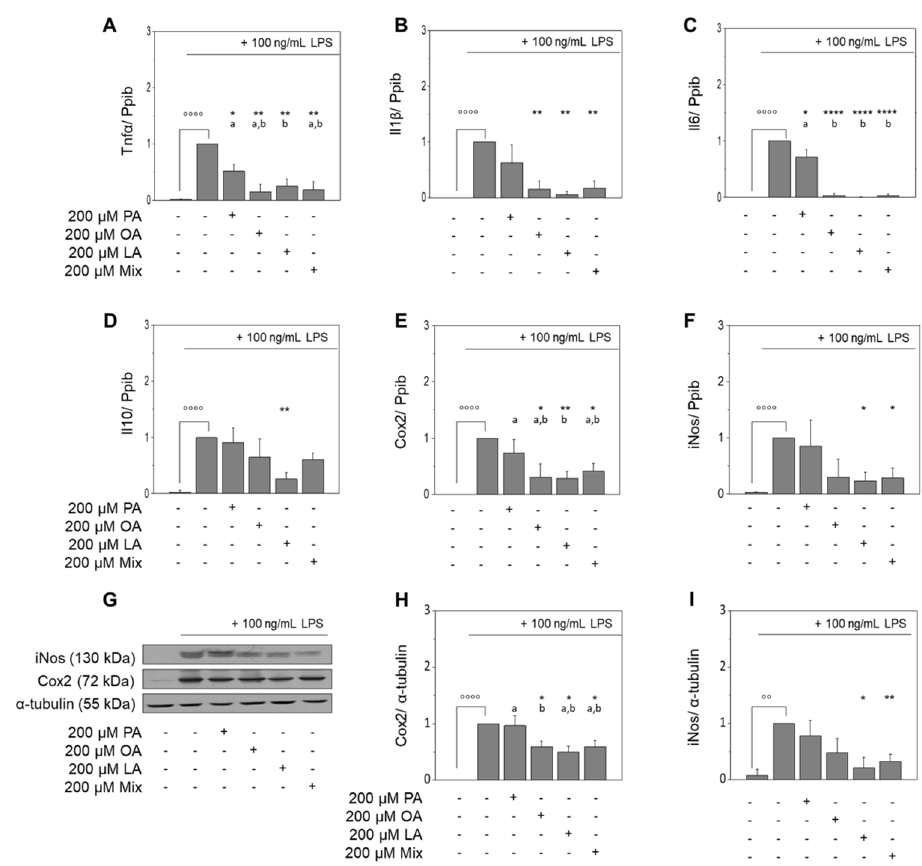
Figure 2. Effects of major fatty acids (FA) of extra virgin olive oil on the expression of inflammatory markers. Selected FAs diminished LPS-induced expression of Tnf α , Il1 β , Il6, and Il10 mRNA ( A – D ) and of iNos and Cox2 mRNA and protein expression ( E – I ) in murine RAW264.7 macrophages. Cells were pre-incubated with serum-free medium, oleic acid (OA), linoleic acid (LA), palmitic acid (PA), or a defined FA mixture (Mix) of the mentioned FAs (80:10:10) for 4 h followed by a co-incubation with 100 ng/mL LPS for additional 20 h. Control samples were cultured with medium only; values of positive controls (LPS) were defined as 1. Expression of mRNA and protein was normalized to Ppib or α -tubulin, respectively. Western blots shown here are representative examples of the blots used for densitometry. Data are shown as mean expression levels ± standard deviation of four independent biological replicates. Significant differences compared to the untreated control (°° p < 0.01, °°°° p < 0.0001), to the LPS control (* p < 0.05; ** p < 0.01; *** p < 0.001; **** p < 0.0001) and between samples ( a,b p < 0.05; different small letters represent statistically different values) were obtained by RM one-way ANOVA tests.